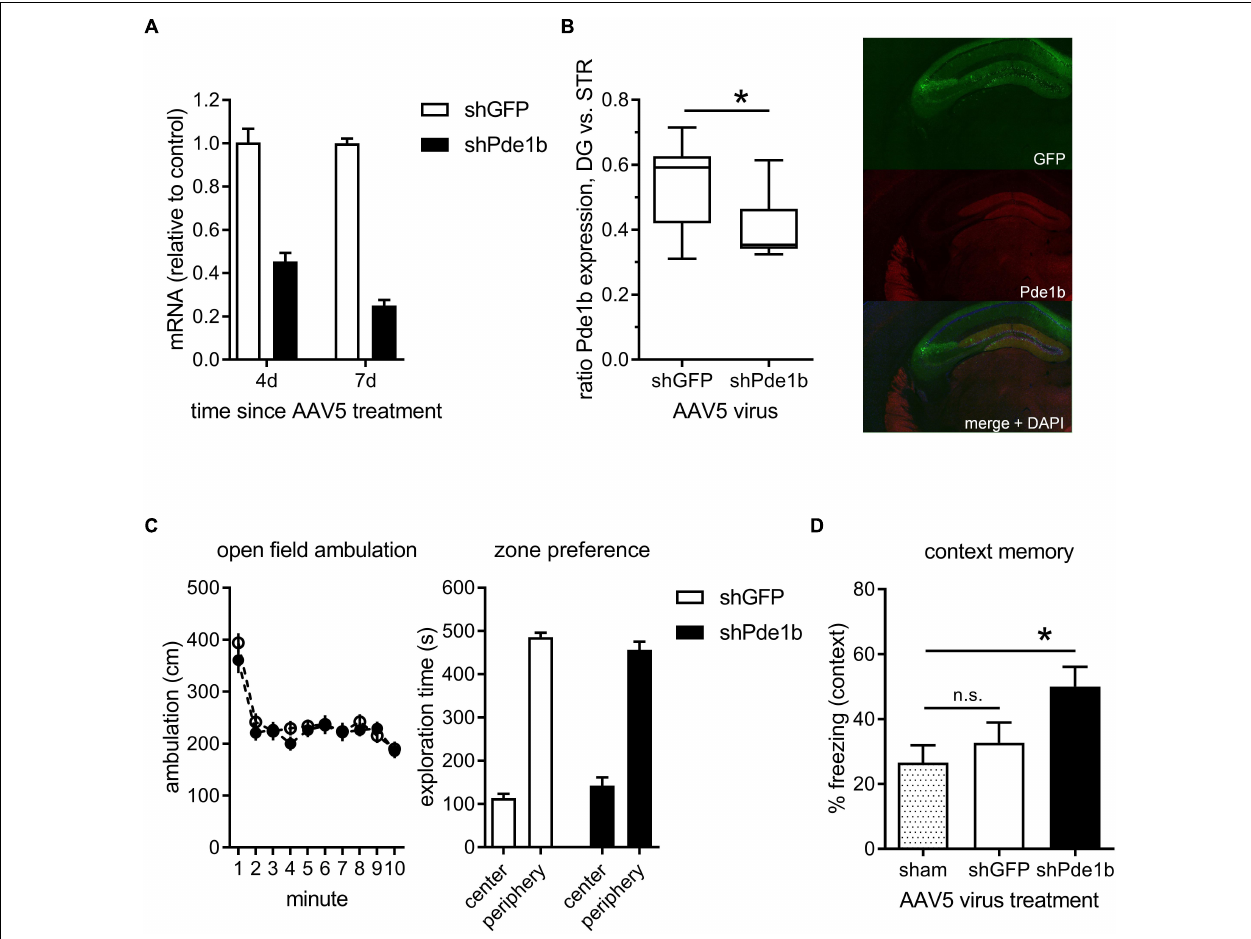
FIGURE 1 | Effects of intra-hippocampal RNAi knock-down of PDE1B on open field exploration and contextual fear memory. (A) Pde1b mRNA levels measured in hippocampal cultures treated with shGFP control or shPde1b expressing AAV5 ( n = 4 per treatment). PDE1B was efficiently targeted by the shRNA. (B) PDE1b protein expression 3 weeks after transfection with shPde1b or control AAV. Left: Box and whisker plots showing the expression of PDE1B in DG normalized to staining intensity in STR of the same animals (shGFP: n = 12; shPde1b: n = 15). A significant reduction in the relative expression of PDE1B protein between DG and STR was observed after shPde1b treatment. Right: Example image showing green fluorescence derived from a GFP marker co-expressed form the AAV5-shRNA vector, and PDE1B protein expression. (C) Open field exploration in mice treated with shPde1b ( n = 20) or shGFP control ( n = 20) virus. Left: Ambulation over the 10 min trial duration. Right: Time in the center and periphery of the open field. No difference was found between treatment groups. (D) Contextual fear memory was enhanced by PDE1B knockdown. Time spent freezing upon re-exposure to the training context is shown. shPde1b ( n = 17), but not shGFP ( n = 17), treated mice froze significantly more than sham controls ( n = 13) on test. The mean ± s.e.m. is shown for all groups. Significant differences from vehicle control are indicated by an asterisk ( ∗